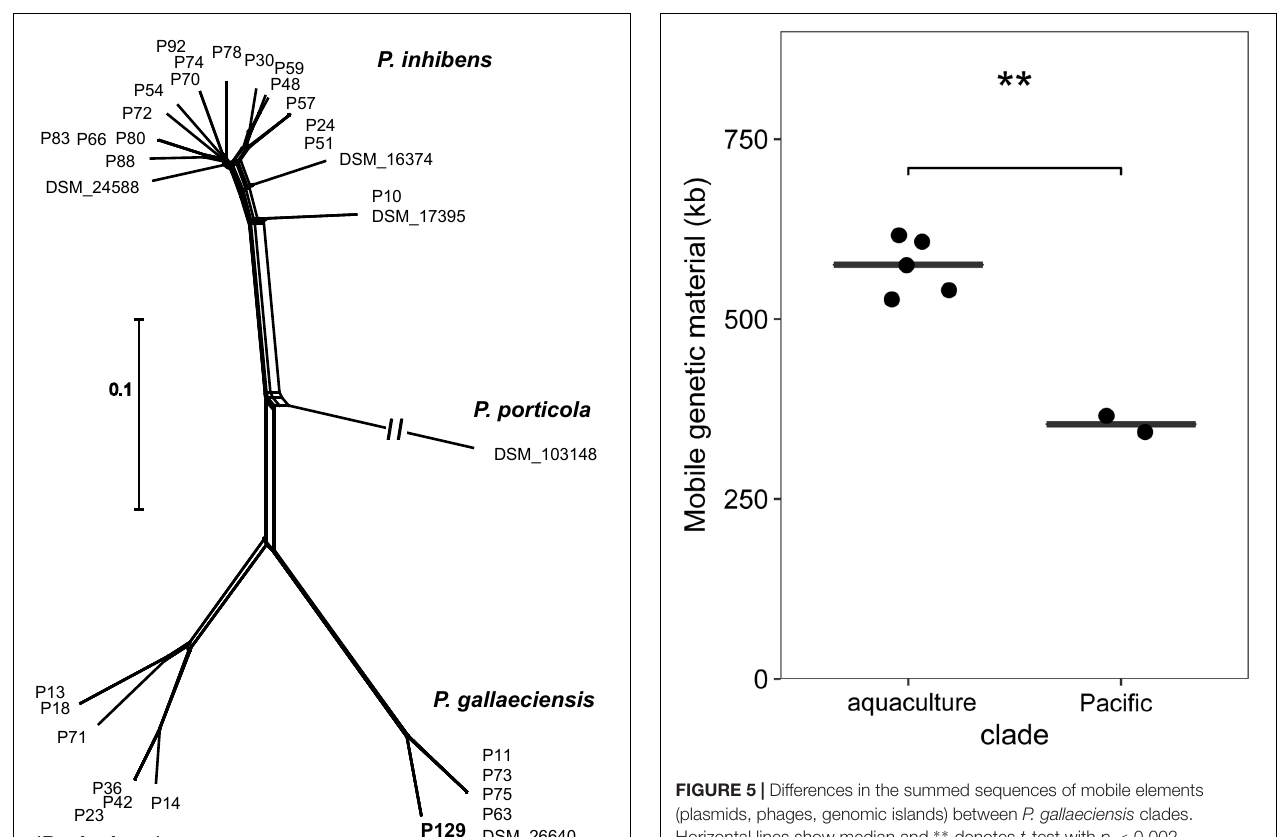
lyase enzyme complex (PhnGHIJKLM) present in all other P. gallaeciensis .